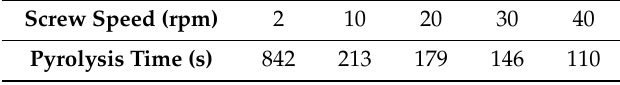
Table 1. The correspondence between pyrolysis time and screw speeds.